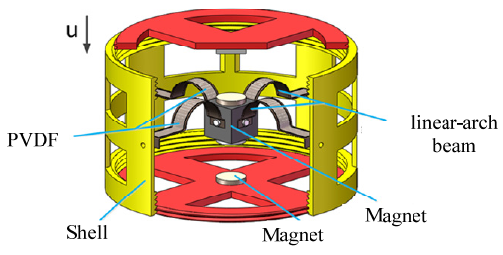
Figure 1. Multifield coupled multidirectional piezoelectric energy harvester.